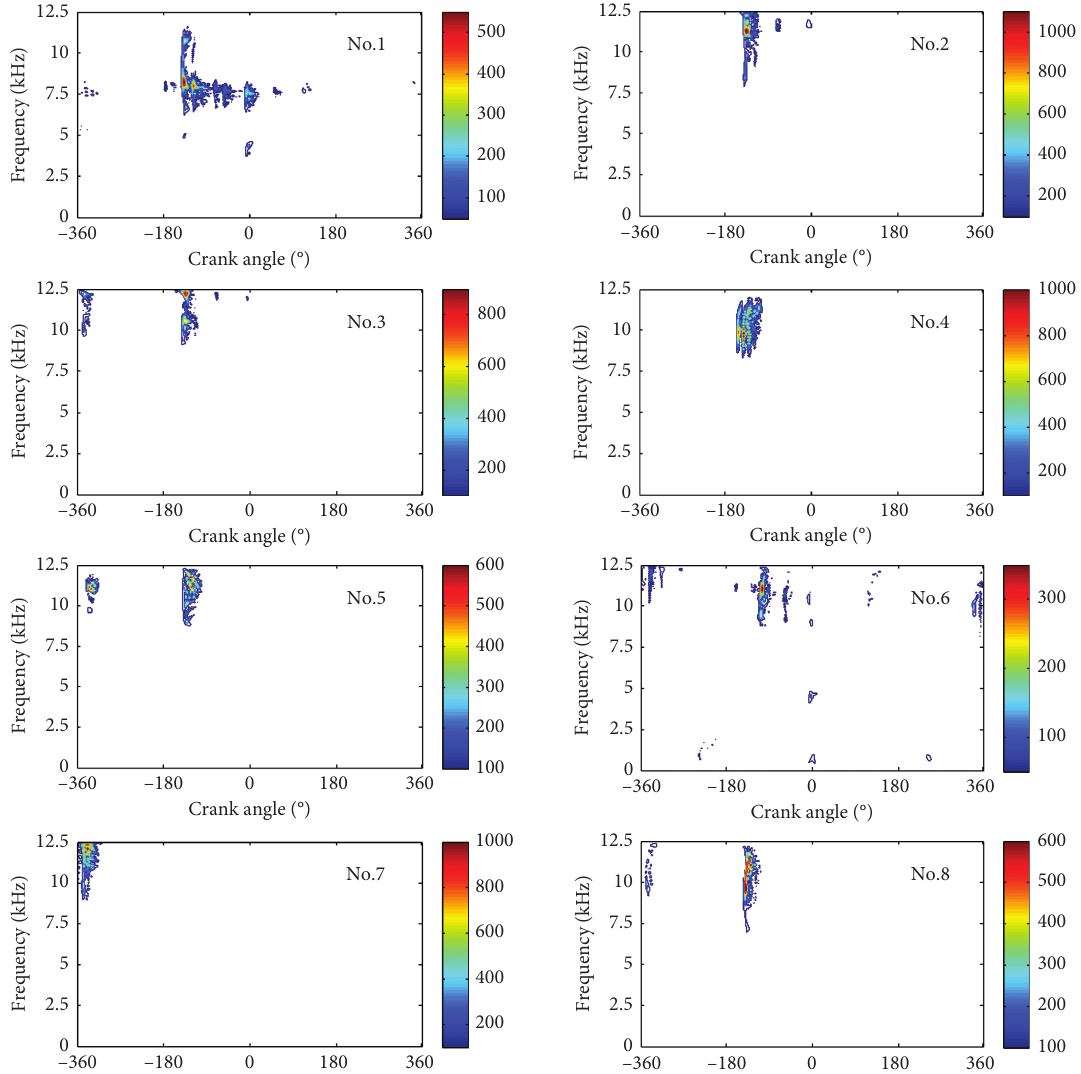
Figure 10: Time-frequency analysis of the diesel engine vibration signals under eight operating conditions using